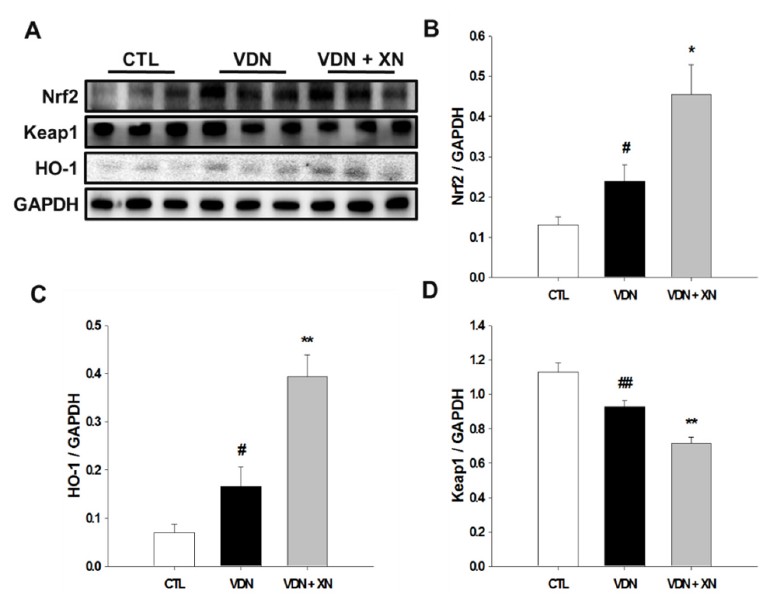
Figure 8. Effects of XN treatment on protein levels of Nrf2, HO-1, and Keap1 through western blot analysis. Figure 8. ( A ) E ff ects of XN treatment on protein levels of ( B ) Nrf2, ( C ) HO-1, and ( D ) Keap1 through GAPDH was a control for protein loading. Results were obtained from six independent experiments, and western blot analysis. GAPDH was a control for protein loading. Results were obtained from six densitometric analysis of autoradiograms is shown as ratio to GAPDH. Each point represents the mean ± independent experiments, and densitometric analysis of autoradiograms is shown as ratio to GAPDH. SEM, n = 10. # p < 0.05, ## p < 0.01 compared with the control group. * p < 0.05, ** p < 0.01 compared with VDN Each point represents the mean ± SEM, n = 10. # p < 0.05, ## p < 0.01 compared with the control group. group. * p < 0.05, ** p < 0.01 compared with VDN